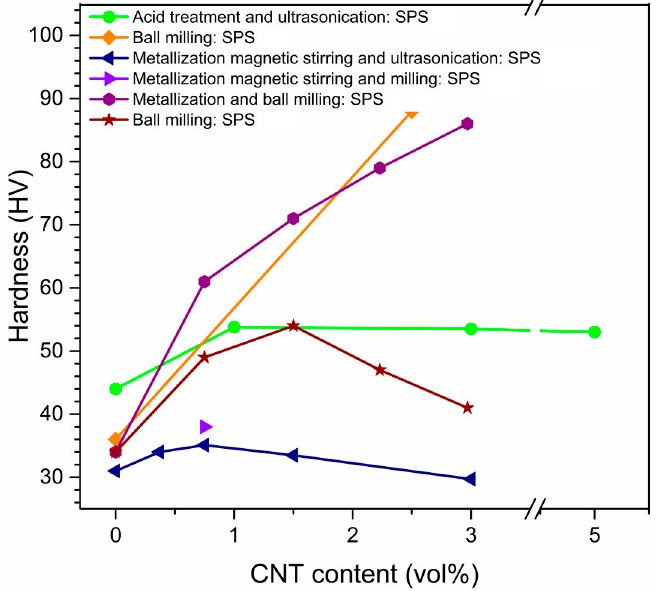
Figure 8. Hardness of some spark plasma sintered (SPSed) CNT-Al matrix nanocomposites fabricated by various dispersion methods [13,16,36,95].